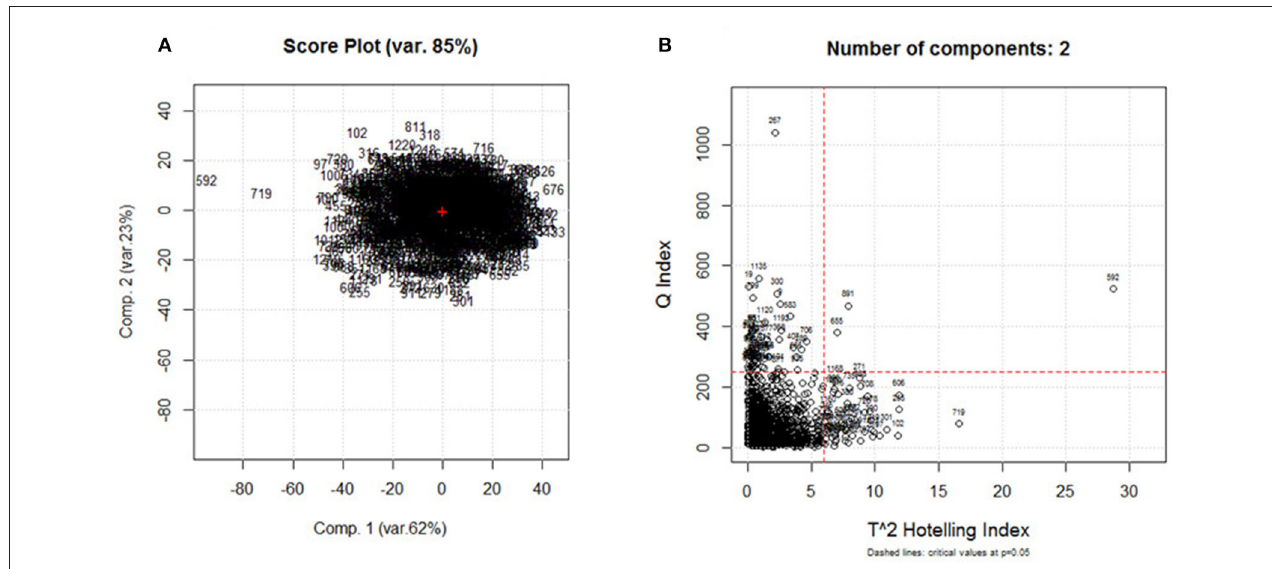
FIGURE 2 | (A) Score plot obtained on the principal component analysis (PCA) of the spectral data set (1,230 samples × 525 variables) and (B) T 2 vs. Q diagnostic plot.